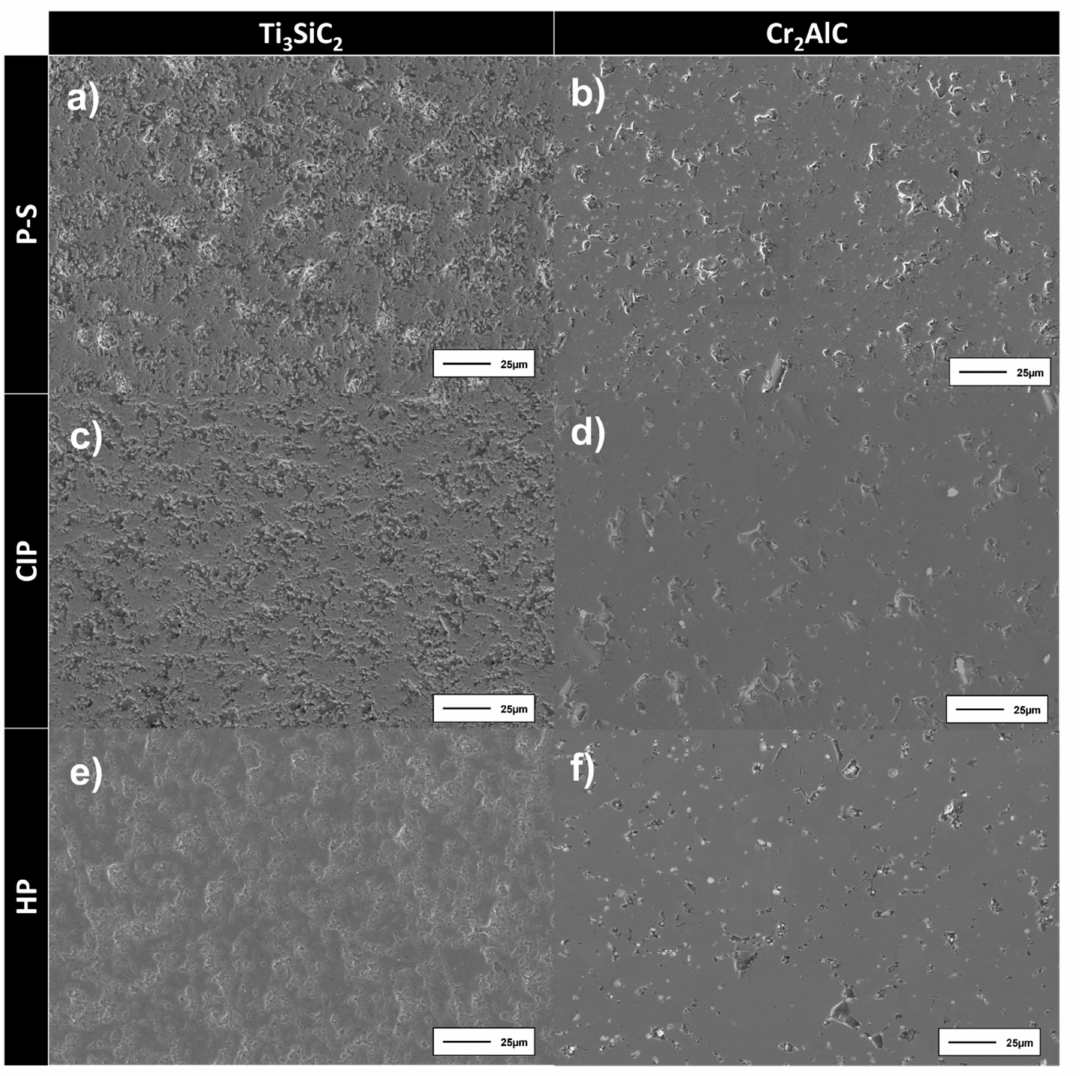
Figure 6. SEM micrographs of consolidated samples by different routes: ( a ) uniaxially pressed and sintered (P-S) Ti 3 SiC 2 ; ( b ) uniaxially pressed and sintered (P-S) Cr 2 AlC; ( c ) cold isostatic pressed and sintered (CIP) Ti 3 SiC 2 ; ( d ) cold isostatic pressed and sintered (CIP) Cr 2 AlC; ( e ) hot-pressed (HP) Ti 3 SiC 2 and ( f ) hot-pressed (HP) Cr 2